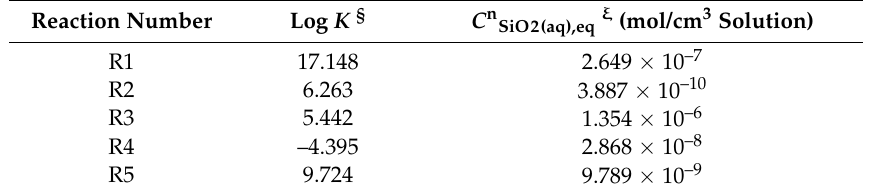
Table 1. Equilibrium constants of the overall reaction considered in the reactive transport